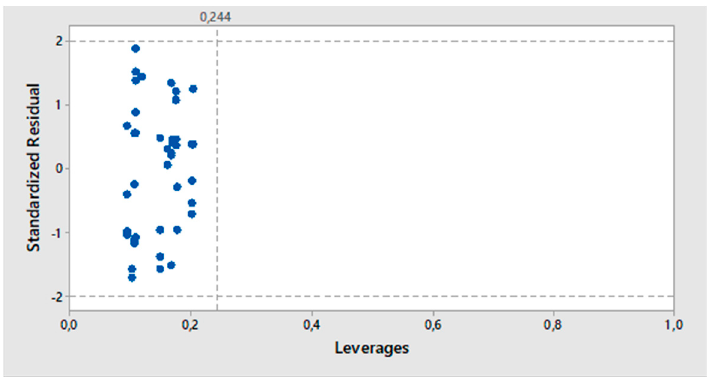
Figure 4. PLS residual vs. leverage plot for the q u max model.